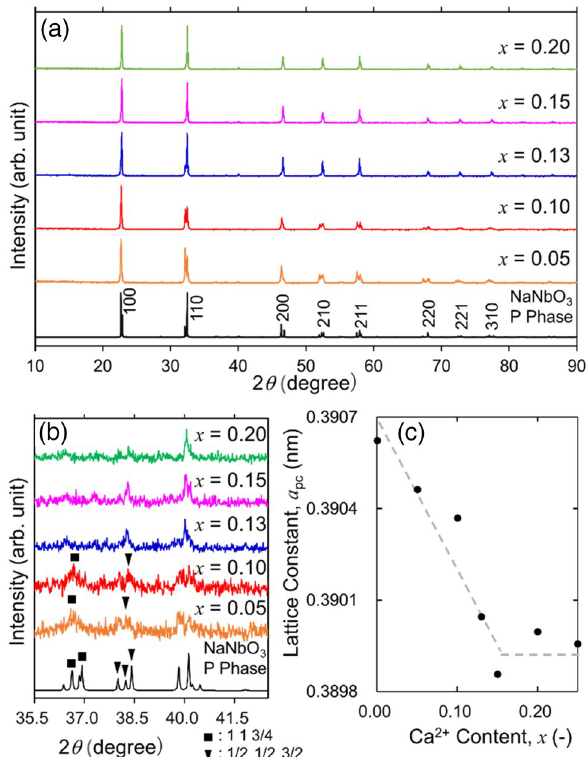
Figure 3. ( a ) XRD patterns of the Ca-modified samples (Ca x Na 1−2 x V x )NbO 3 and ( b ) enlarged view in the range of 35.5° ≤ 2 θ ≤ 42.5°. The solid triangles indicate the 1/2 1/2 3/2 reflections and the squares the 1 1 3/4 ones, both of which are characteristic for the AFE-P phase 55 . ( c ) Composition ( x ) dependence of the lattice parameter a pc of the pseudocubic unit cell.